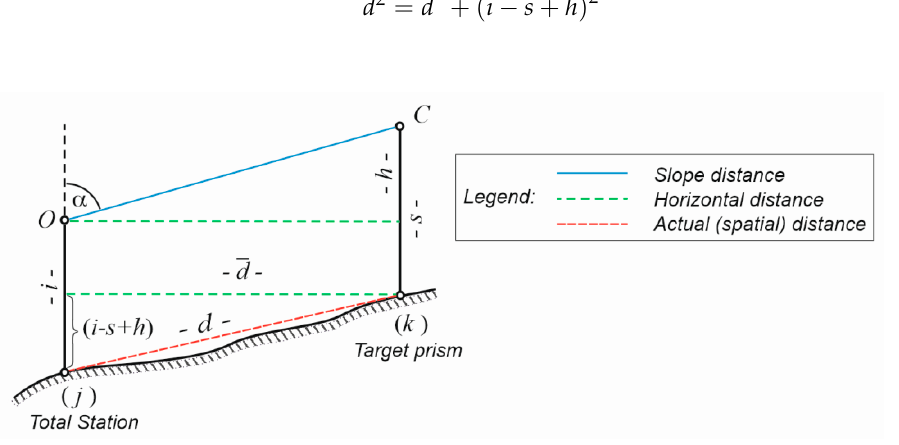
Figure 2. The principle of indirect levelling ( O —tilt axis; C —target point; d ̅ —horizontal distance; d —spatial distance; i —height of instrument; s —height of signal/target; h —the difference in elevation; α —vertical angle).